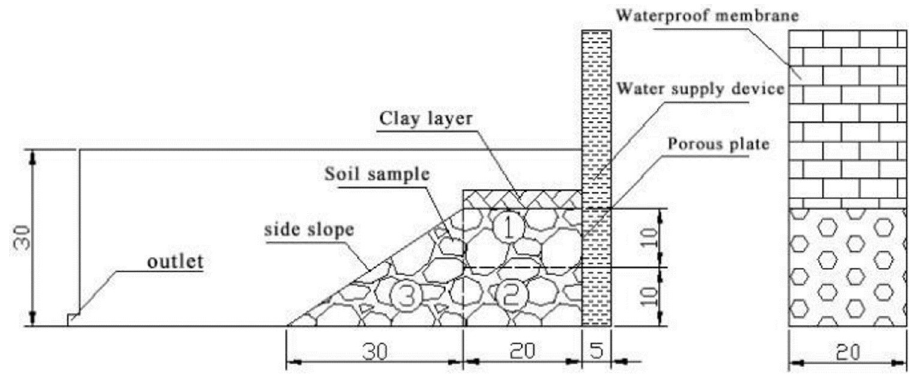
Fig 11. Schematic diagram of the laboratory model. The unit of length scales is centimeter, and the model was divided into three areas numbered with circled numbers.